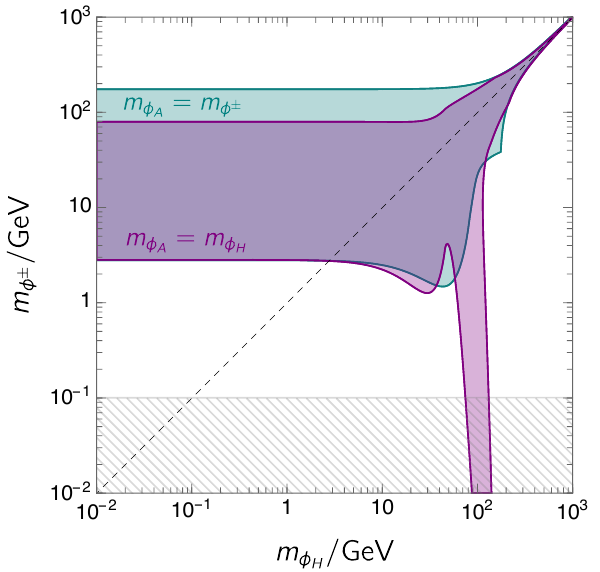
Figure 1 . The fake doublet masses allowed at the 3 σ level from EWPT for the cases m φ (green) and m φ = m φ (purple). The hatched region is excluded as explained in the A H